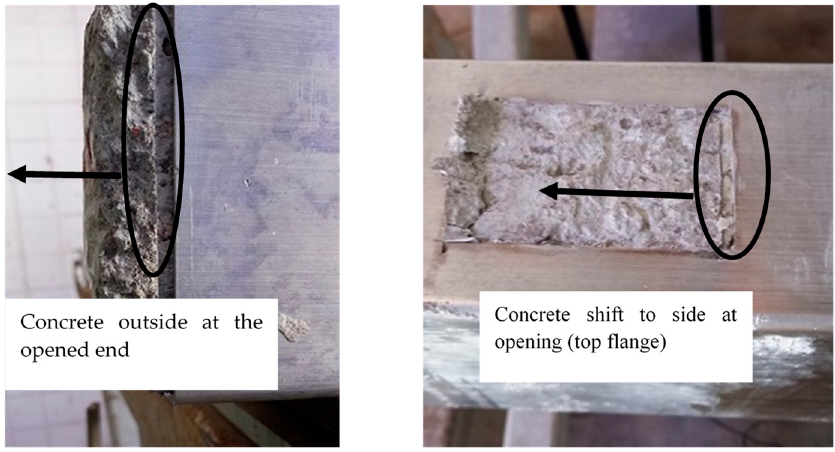
Figure 5. Typical infill concrete material failure mode.